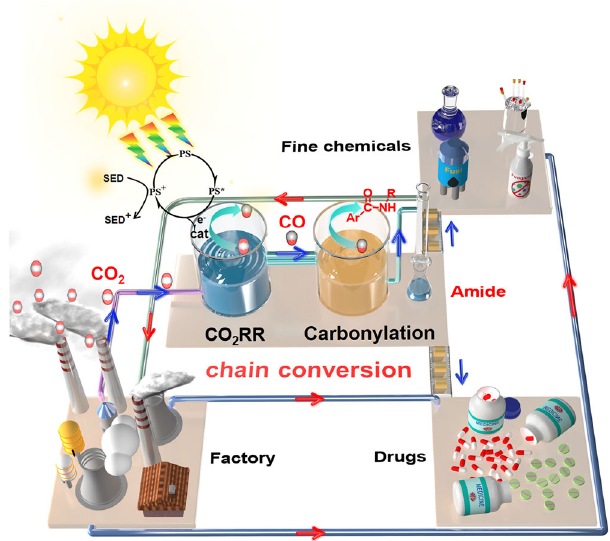
Fig. 1 The tandem coupling of photocatalytic CO 2 RR and carbonylation reaction for the utilization of CO 2 photoreduction product. PS photosensitizer, SED sacri fi cial agent, cat